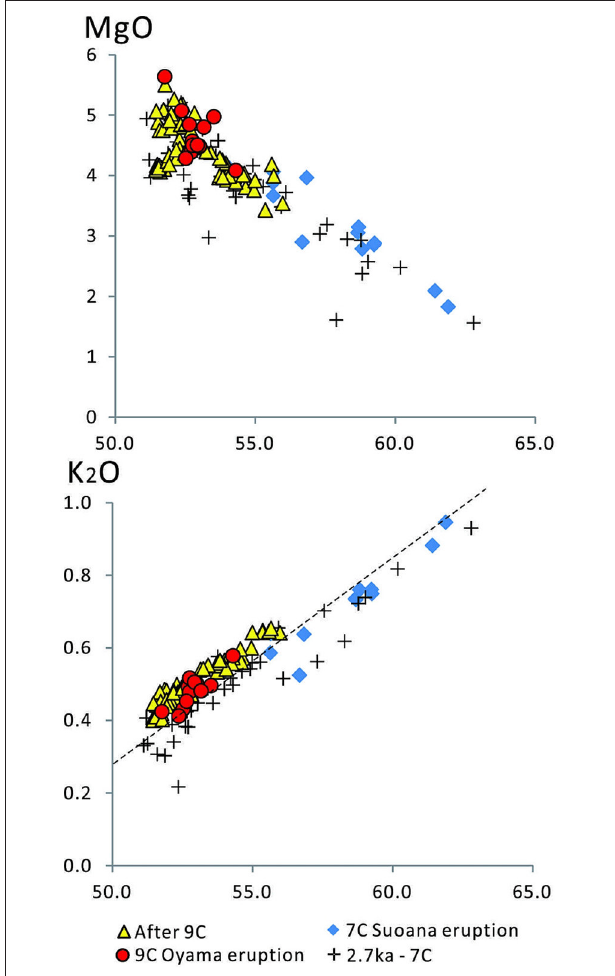
FIGURE 2 | Whole-rock composition of the representative eruptive products of the Miyakejima volcano. Yellow triangles show the composition of the products after the ninth century. Red circles show the products of the ninth-century Oyama-Miikehama eruption. Blue diamonds show the products of the seventh century Suoana-kazahaya eruption. Crosses show the ejecta between 2800 years ago and the seventh century. Broken line shows the approximate boundary between the ejecta before and after the ninth century Oyama-Miikehama